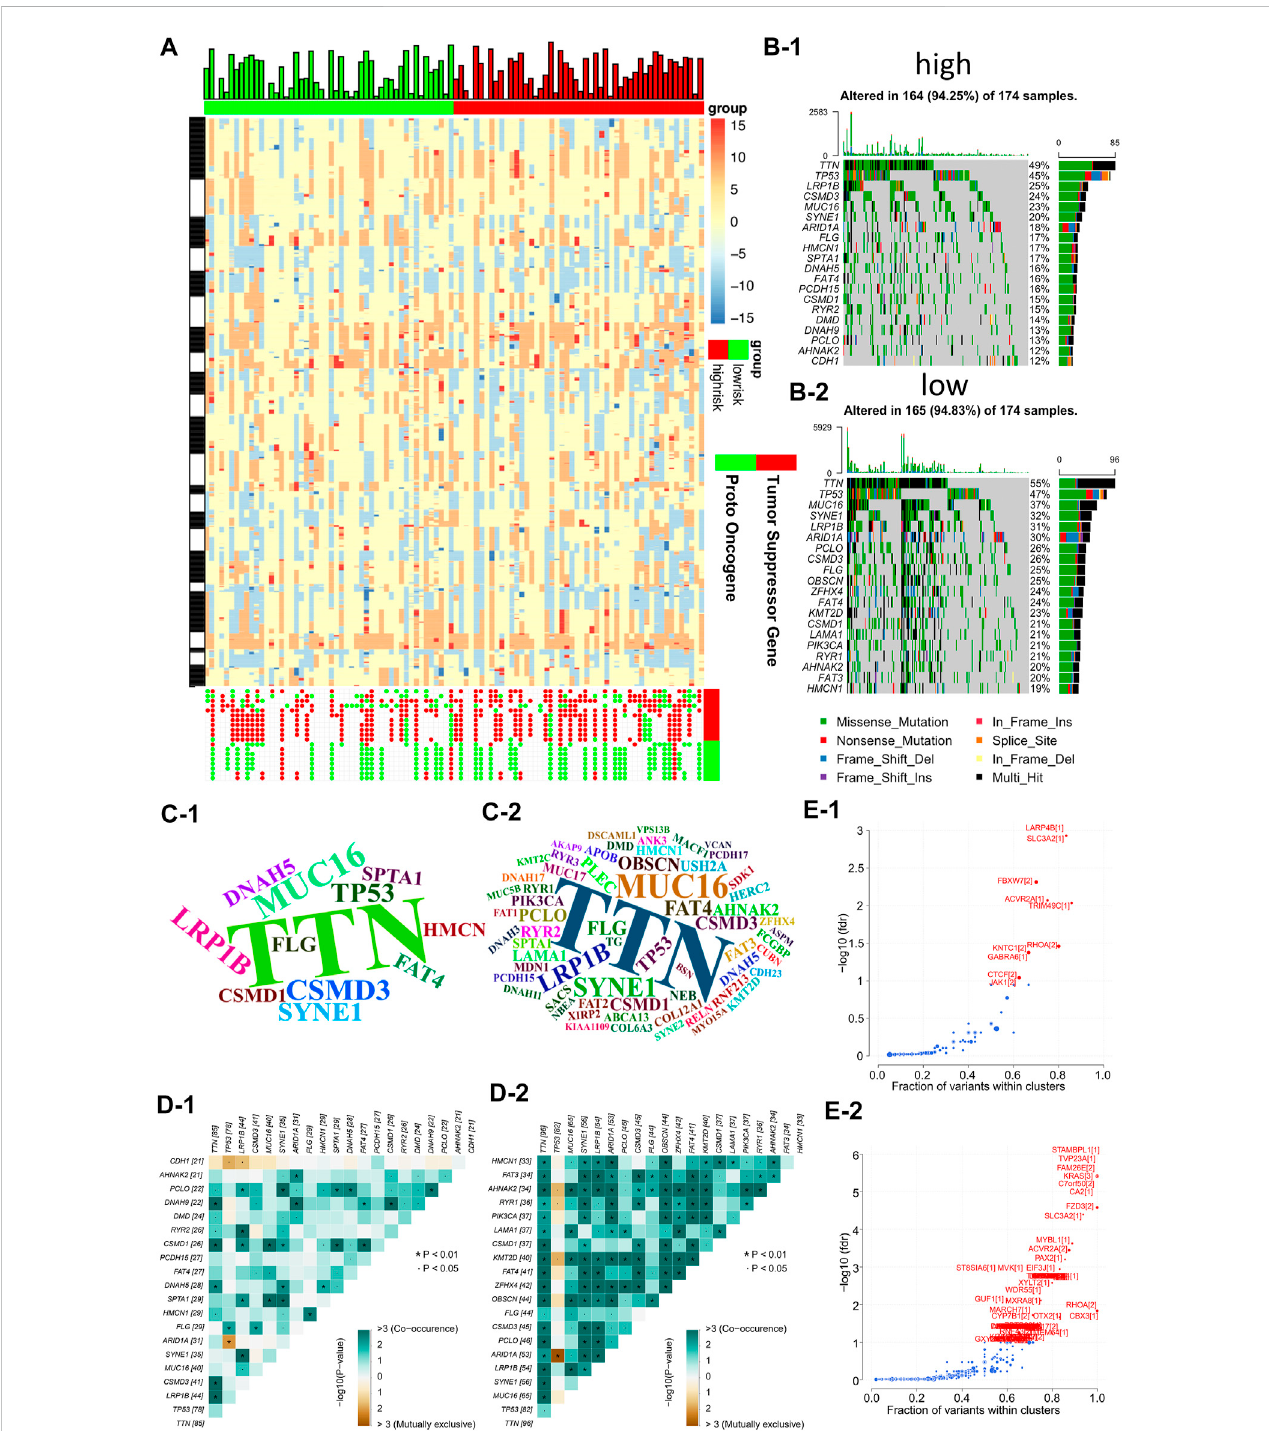
FIGURE 5 Risk models are associated with genomic instability (A) Comparing low and high risk group tumor sectors (top), bar chart showing the altered genome fraction (second top), heatmap showing differential copy number variations (CNV) level (middle) and copy number status of the selected genes showing signi fi cant deletion or ampli fi cation (bottom). (B) Waterfall plot of the top 20 mutant genes in the high and low risk groups (B-1: high risk group, B-2: low risk group). (C) Wordclouds were drawn with size of scripts bound up with amounts of samples containing certain mutant genes in the high and low risk groups (C-1: high risk group, C-2: low risk group). (D) Correlation heat map to show the degree of correlation between mutant genes in the high and low risk groups (D-1: high risk group, D-2: low risk group). (E) Volcano map used to demonstrate mutation driver genes in the high and low risk groups (E − 1: high risk group, E − 2: low risk